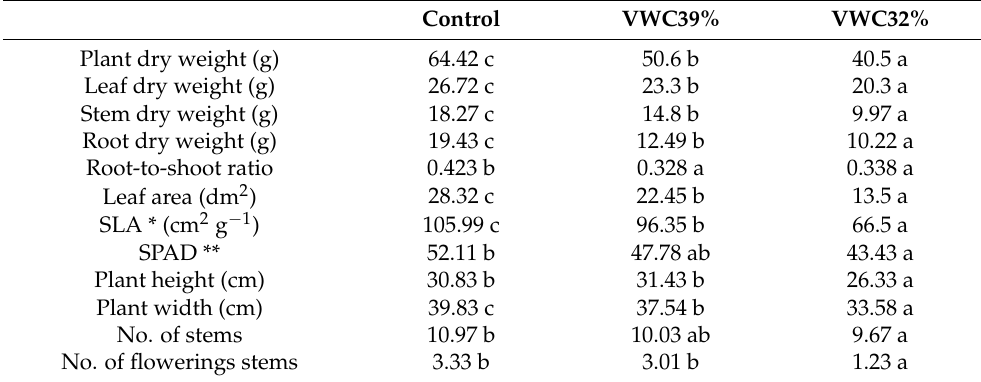
Table 3. Growth and development parameters of Hebe plants under three different volumetric water contents (VWCs) over 152 days: control (49.28% VWC), VWC39% (VWC 38.44%), and VWC32% (VWC